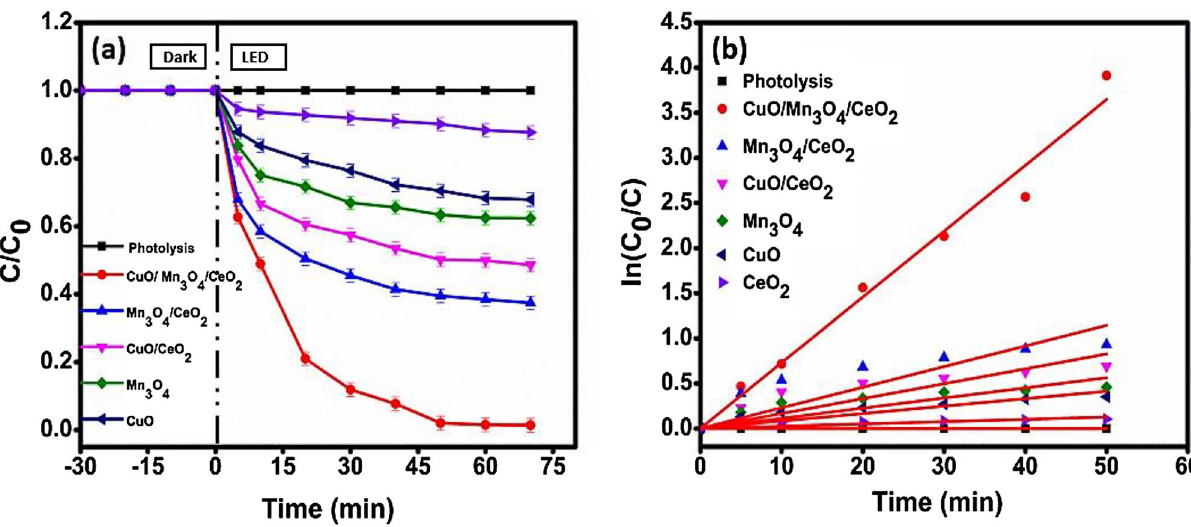
Figure 15. ( a ) Degradation profile and ( b ) kinetics plot for comparative study of different samples of the catalyst with photocatalyst CMCu for MG dye degradation.